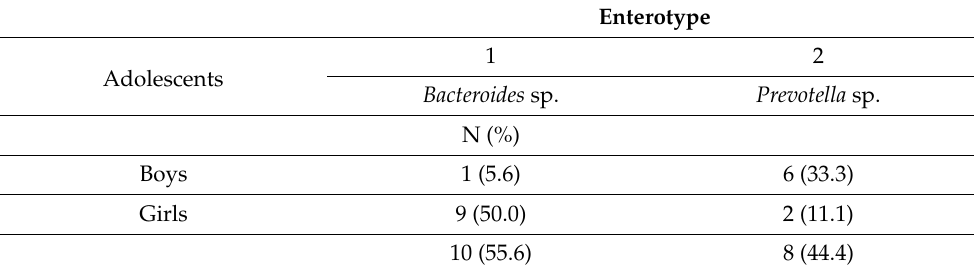
Table 5. Enterotype by gender in adolescents.